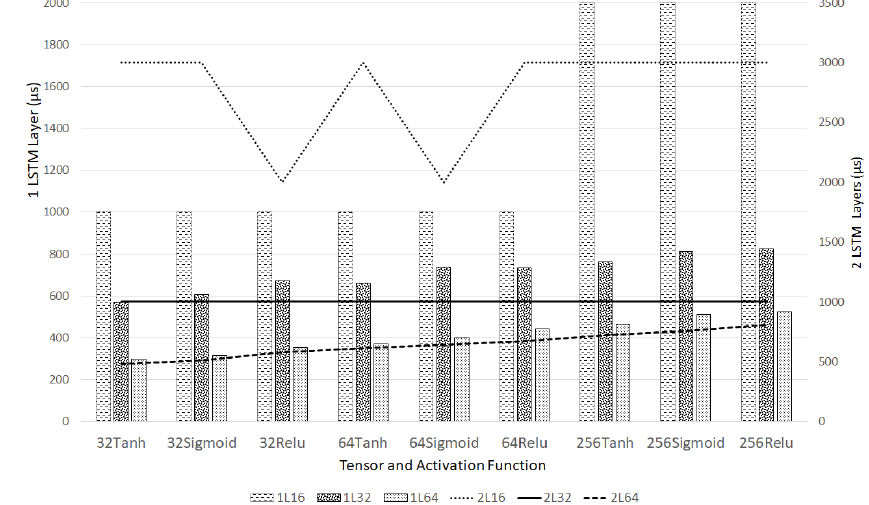
Figure 12. Training time per step for 1 and 2 layer long-short term memory (LSTM) with 32 upto 256 LSTM unit, with Convolution channel 16, 32, and 64, and activation function Tanh, Sigmoid, and